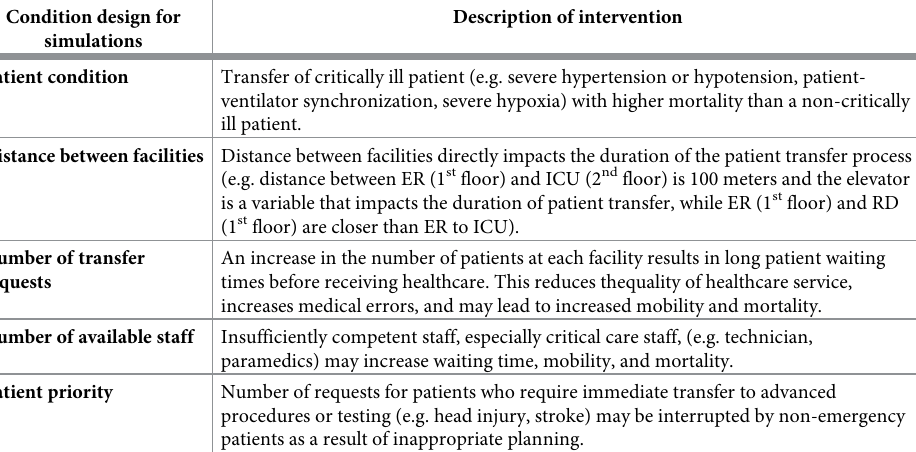
Table 2. Conditions for the simulation